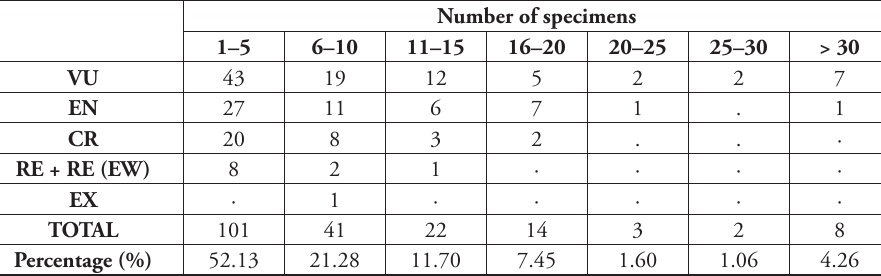
Table 2. Number of taxa according to the specimens’ range and the IUCN